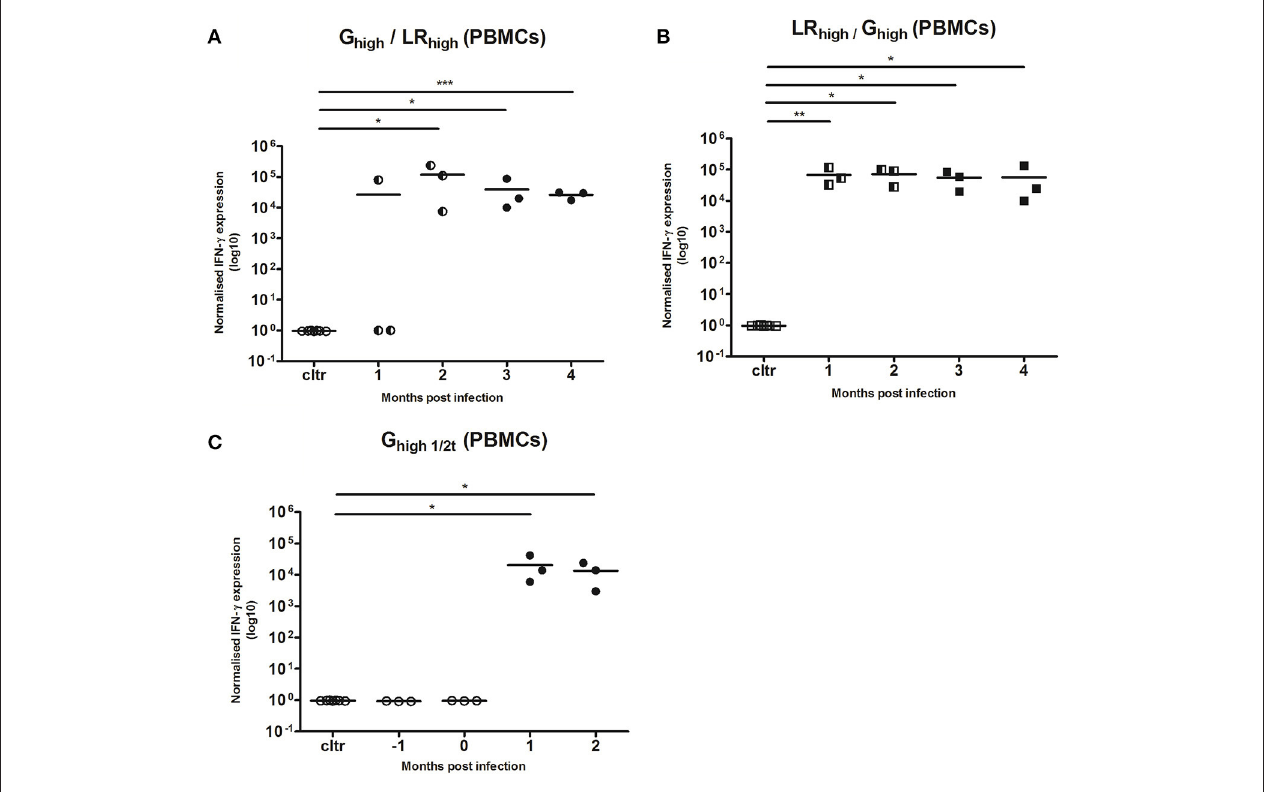
FIGURE 6 | Relative normalized IFN- γ expression in PBMCs after a consecutive IPB-G and IPB-LR inoculation. PBMCs were isolated monthly from pigs orally infected with (A) a high dose of the IPB-G strain followed 60 days later by a high dose of the IPB-LR strain (G high /LR high ) or (B) reversed infection model (LR high /G high ). Piglets infected with a high dose of the IPB-G strain at day 60 served as a control (C) (G high1 / 2t ). Cells were restimulated in vitro with TLA and IFN- γ mRNA was quantified with RT-PCR. The thick lines indicate the group mean. The significance level: * P < 0.05, ** P < 0.01; *** P < 0.001.